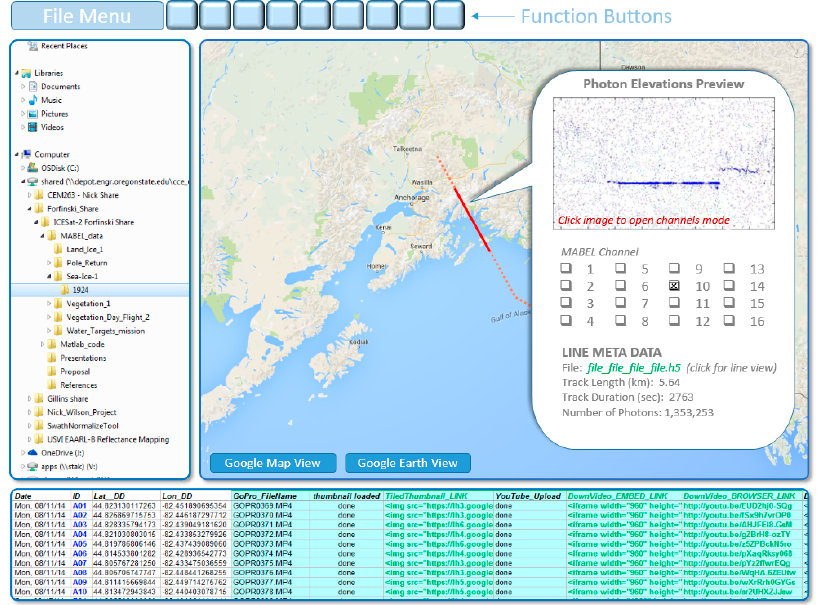
Figure 1. MABEL Viewer prototype interface for interactive identification of bottom returns from the Multiple Altimeter Beam Experimental Lidar (MABEL).